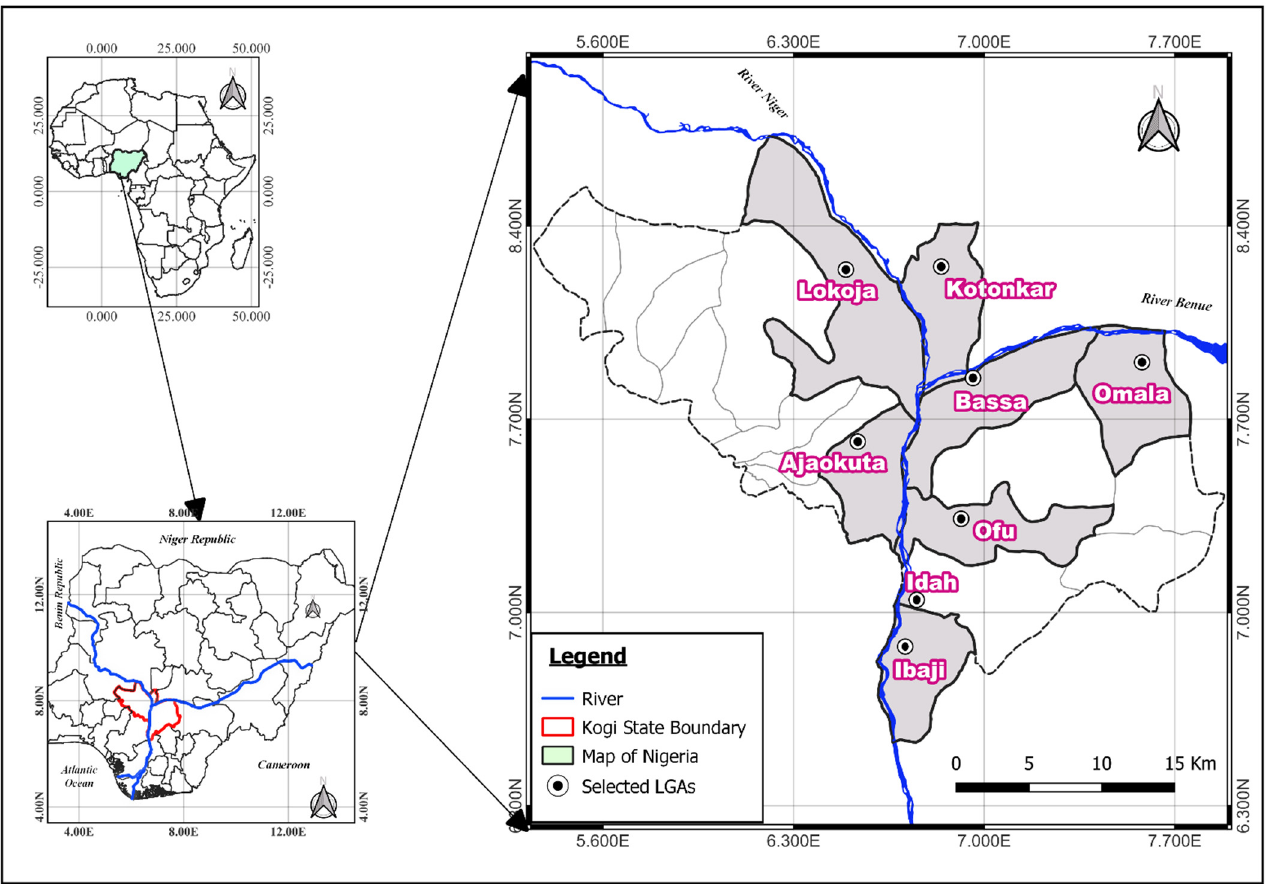
Figure 1. Study area map.